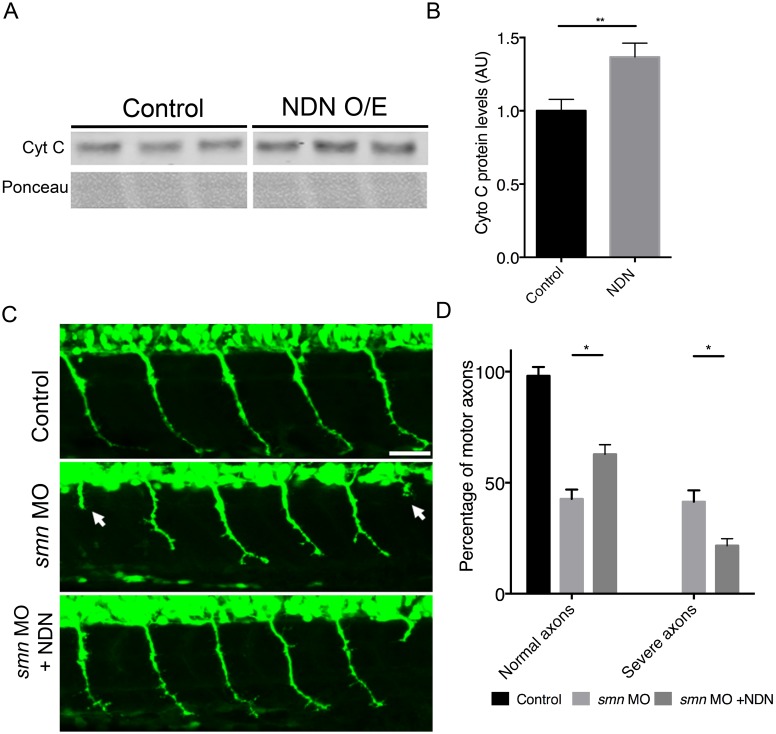
Overexpression of necdin ameliorates the motor axon outgrowth phenotype in smn morphant zebrafish.(A) Western blotting of cytochrome C, an electron transport chain protein showed an increase in NDN overexpressing embryos suggesting an increase in mitochondrial biogenesis. (B) Cyt C protein levels were quantified relative to a loading control. (C) Representative confocal micrographs of motor neuron axons exiting the spinal cord in control (top), smn morphant (middle) and smn morphant over-expressing Ndn (bottom) Tg(hb9:GFP) zebrafish embryos. Note the presence of the axonal outgrowth phenotype associated with smn knockdown (arrow heads) is reduced in the Ndn expressing animals. Scale bars = 50 μM. (D) Bar chart (mean & s.e.m.) showing a significant increase in the number of normal MNs, and a concomitant significant decrease in the number of severely affected MNs, in co-injected smn MO and Ndn mRNA embryos compared to single smn MO injected embryos at 30 hpf. Unpaired two-tailed student t-tests; * p<0.05, ** p<0.01 *** p<0.001. N = 20 embryos per experimental group.